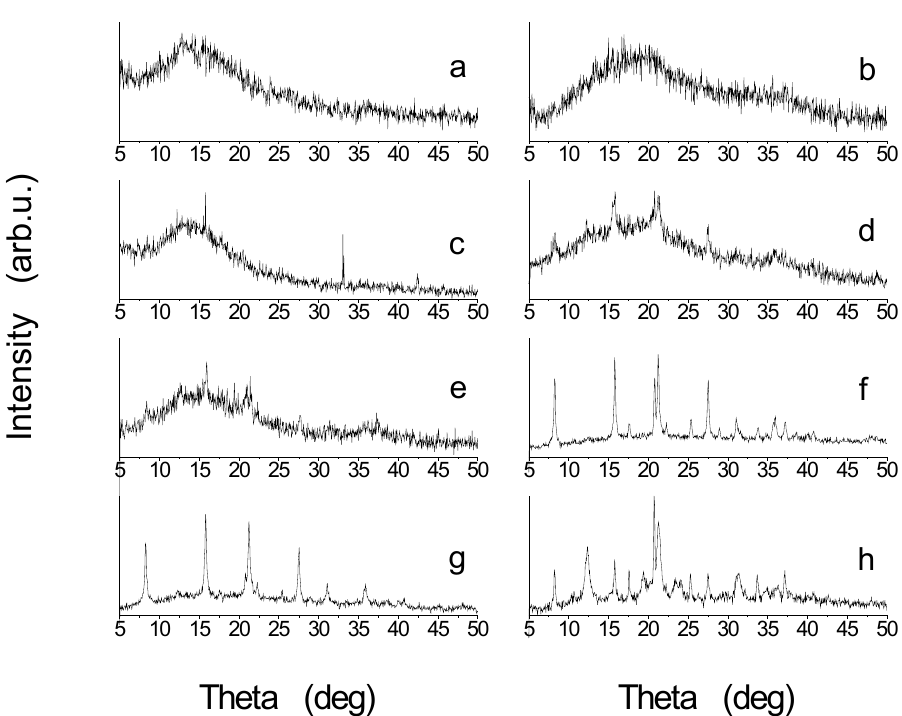
Figure 7. XRD patterns of biogenic materials obtained from Sphaerotilus-Lepthotrix bacteria cultivated in different feeding media: a - Hay, b – Winogradsky, c – Lieske, d - ISSL, g – ISSLk, e - Adler, f – AdlerK, h – Fedorov. Table 3.